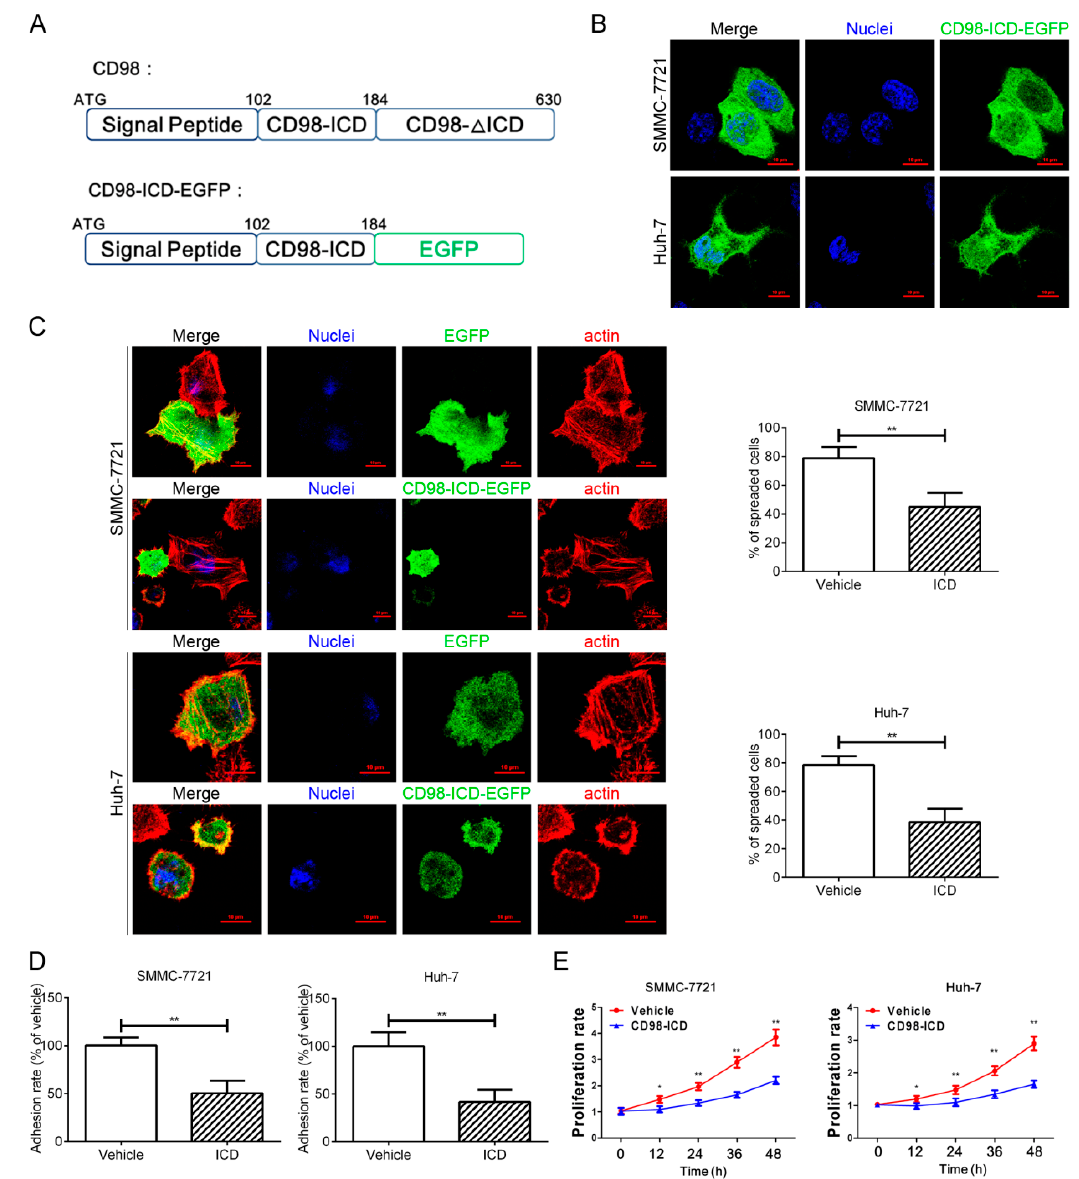
Figure 1. CD98-ICD inhibits SMMC-7721 and Huh-7 cell adhesion, spreading and proliferation in vitro. ( A ) Schematic illustration of CD98 and CD98-ICD-EGFP. CD98 is a type II transmembrane protein, and the N-terminal is located in the cytoplasm. The N-terminal signal peptide and intracellular domain of CD98 (CD98-ICD) were fused with EGFP to create CD98-ICD-EGFP; ( B ) representative distribution of CD98-ICD-EGFP in SMMC-7721 and Huh-7 cell lines. SMMC-7721 (5 × 10 4 ) or Huh-7 cells (5 × 10 4 ) were cultured on coverslips and transfected with 2 μ g of CD98-ICD-EGFP for 36 h. The distribution of CD98-ICD-EGFP (green) was visualized with a confocal microscope. Nuclei: blue. Bar, 10 μ m; ( C ) spreading assay of SMMC-7721 and Huh-7 (Vehicle or ICD) cells. The indicated transfected cells (5 × 10 4 ) were cultured on coverslips with 1% Matrigel for 2 h, and then the cells were fixed and stained with rhodamine-phalloidin (red) for visualization. CD98-ICD-EGFP: green; Nuclei: blue. The percentage of spread cells was determined by scoring >100 cells. The data are the mean of the “% of spread cells ± SD” from three independent experiments. Bar, 10 μ m. ** p < 0.01; ( D ) adhesion ability assay. The graphed adhesion rate to the extra cellular matrix as described previously ( n = 3); ( E ) the effects of CD98-ICD on the cell proliferation rate of SMMC-7721 (or Huh-7) cells were detected by staining with WST-1 (water soluble tetrazolium) for the indicated time. The graphs show mean ± SD of three independent experiments. * p < 0.05 and ** p < 0.01.